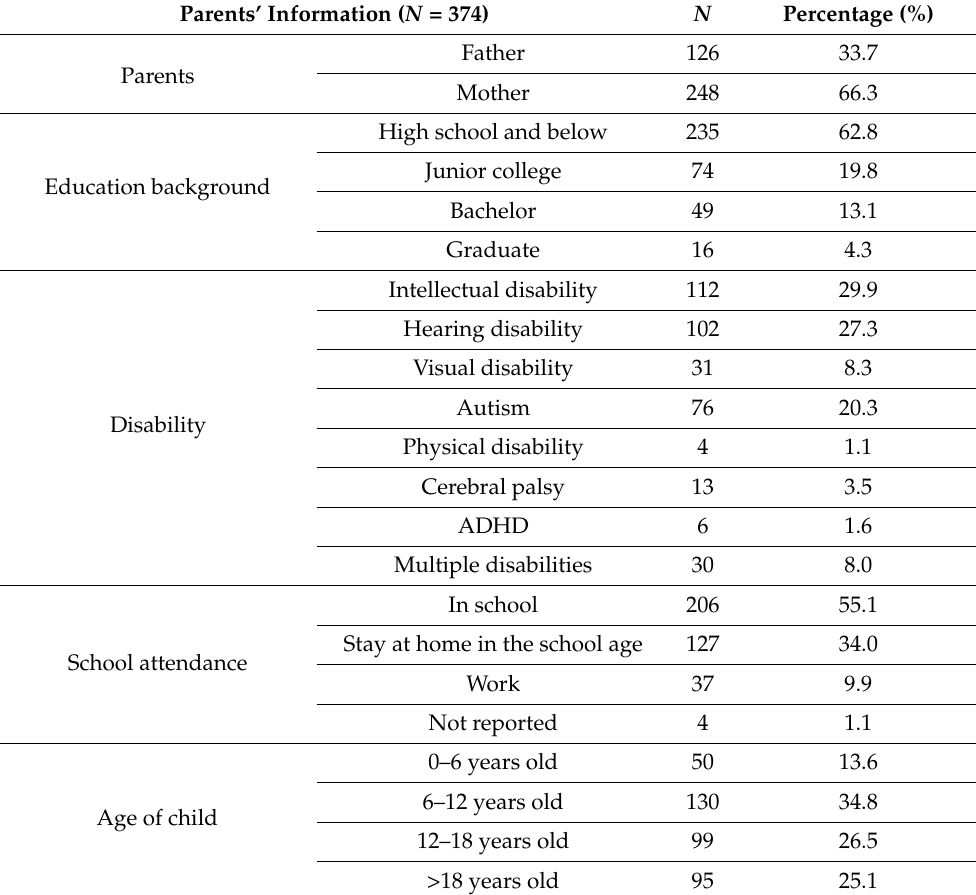
Table 1. Demographic information of